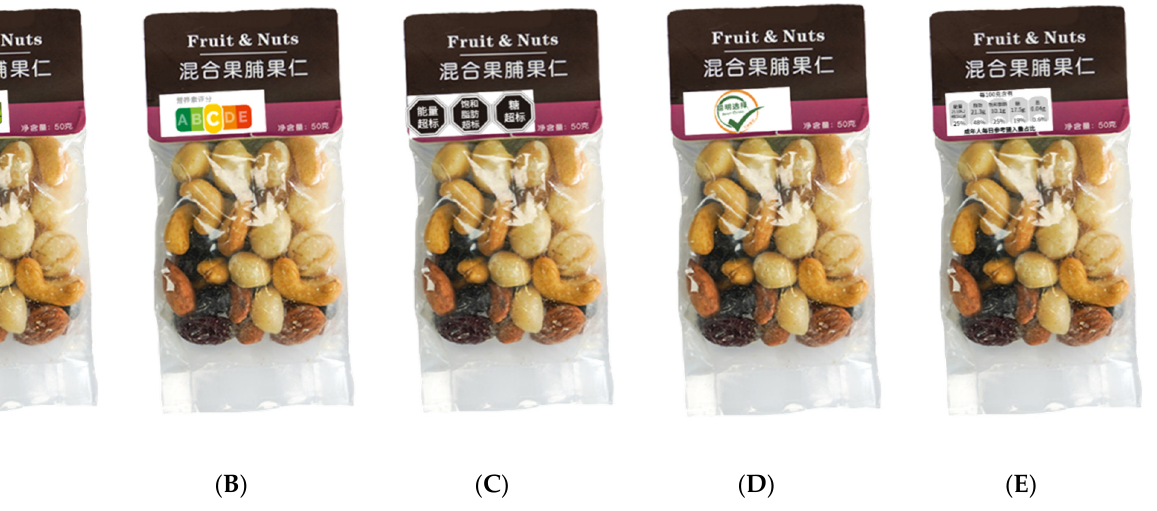
Figure 1. Five FOPL formats included in survey [28]: ( A ) MTL, provides nutrition information as guidancefor a set of nutrients, represented by the UK; ( B ) Nutri-Score, with five categories, using color coding and letters (from A – E ) to summarize the healthfulness of products, represented by France; ( C ) warning labels, denoting foods that are high in certain critical nutrients, represented by Chile; ( D ) health logos: Smart Choice combines several criteria to establish one indication of the healthiness of a product and shows judgement or recommendation with no specific information; first FOP introduced by the Chinese Nutrition Society in China [32] ( E ) GDA, shows information only, with no specific judgement or recommendation; the GDA was replaced with warning labels in Mexico in 2021.